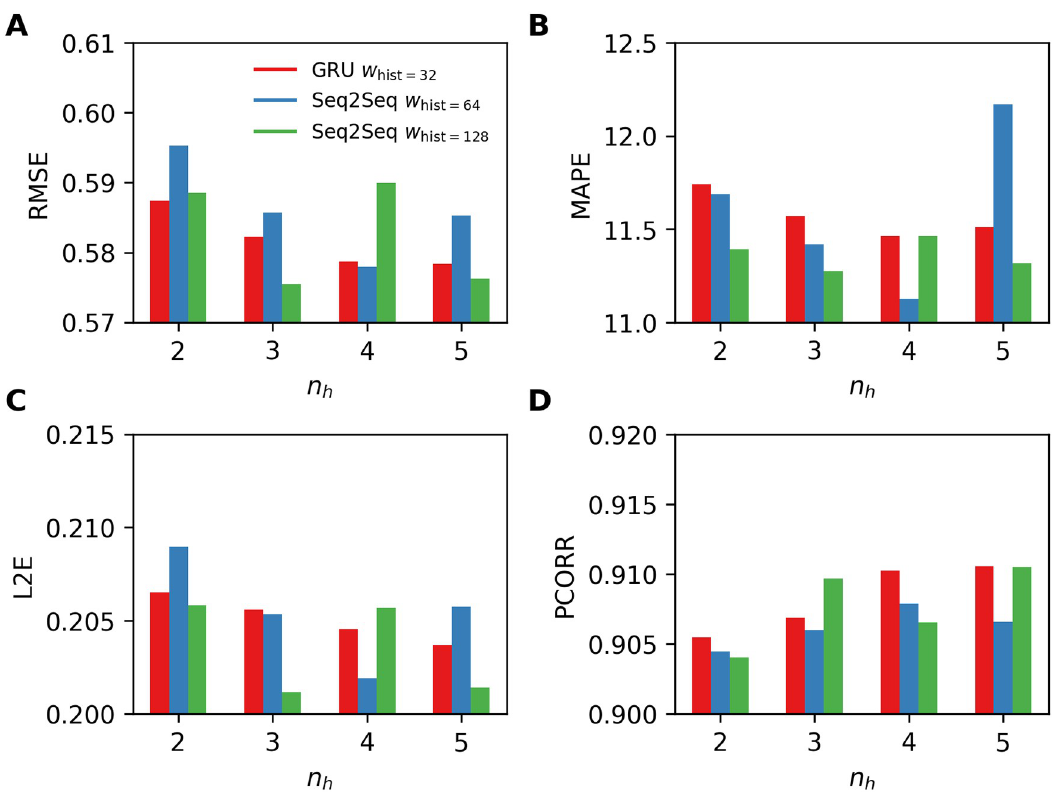
Fig 8. Four performance metrics for one-week-ahead predictions obtained by using RNN-GRU and the Seq2Seq model for varying number of layers n = {2, 3, 4, 5}. A. RMSE, B. MAPE, C. L2E, and D. PCORR. Smaller values are preferable for RMSE, h MAPE, L2E, and larger values are preferable for PCORR. Only the best performing values of w hist are presented.